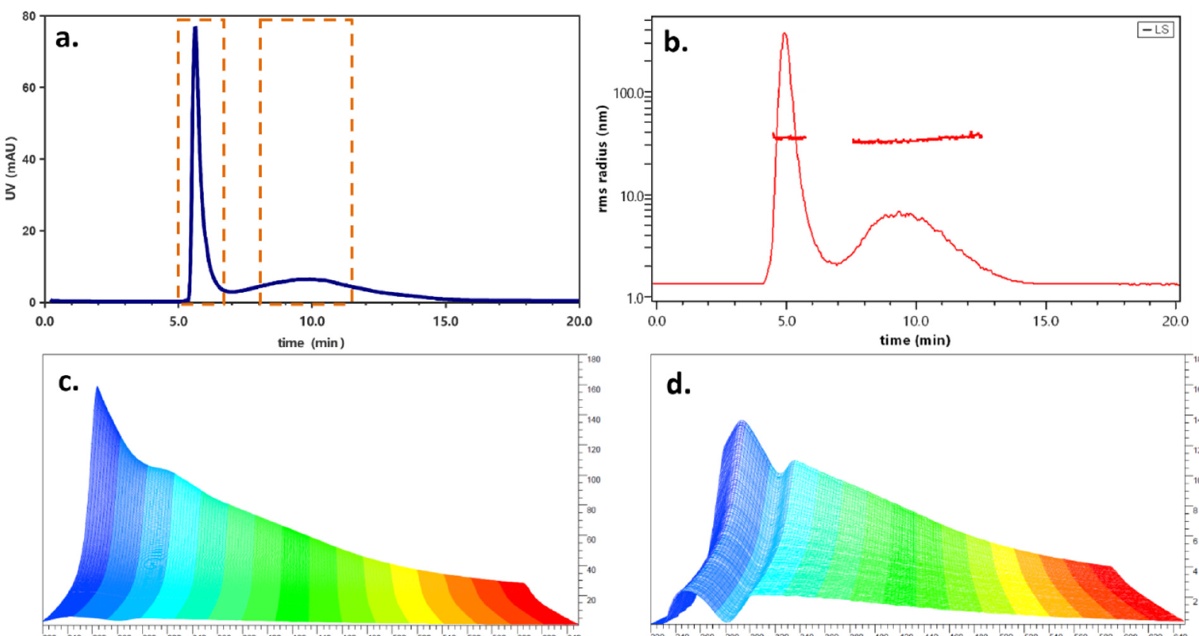
Figure 3. ( a ) UV fractogram at 310 nm; dashed selections: collection ranges. ( b ) Corresponding laser scattering profile. ( c ) UV spectrum of first band. ( d ) UV spectrum of second band.